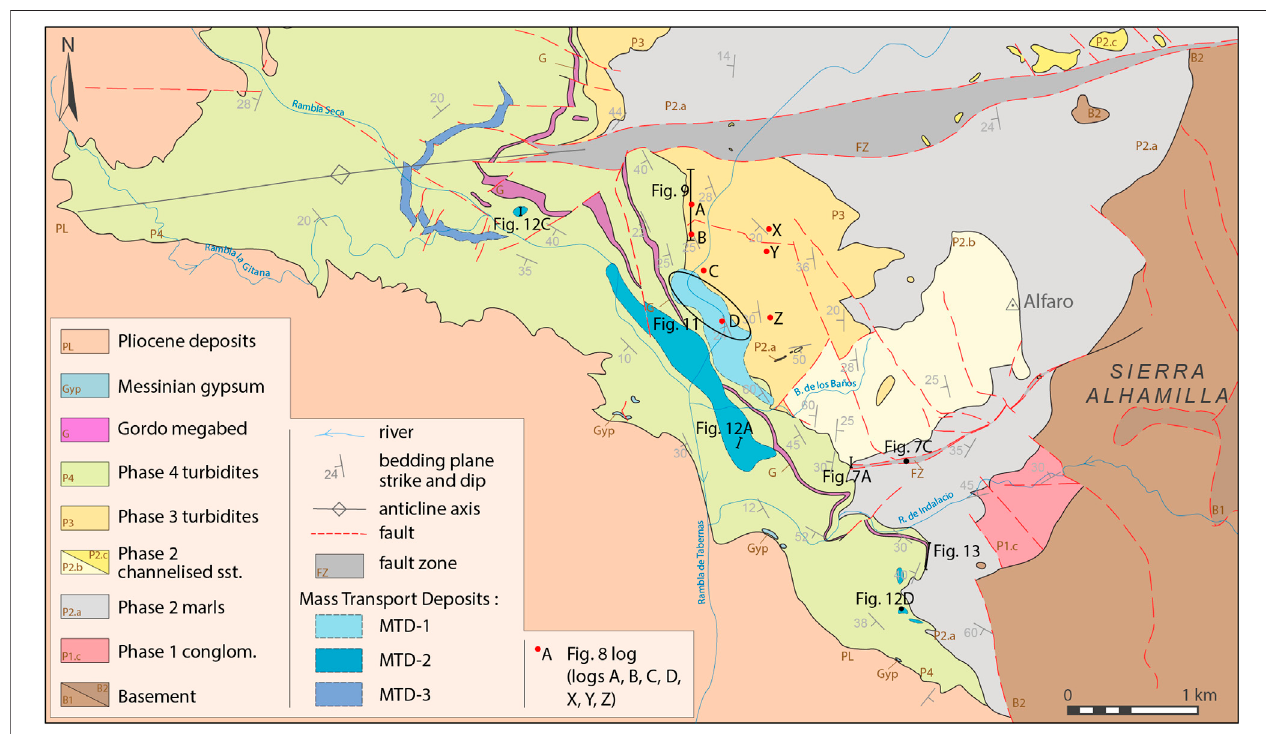
FIGURE 4 | More detailed geological map of the southern Tabernas Basin and the Alfaro sub-basin showing the distribution of the different phases of basin fi lling and the main mass-transport deposits (MTDs 1 – 3). The location of outcrops and measured sections (red dots) illustrated in Figures 7 – 9 , 12 , 13 , 15 are also provided.